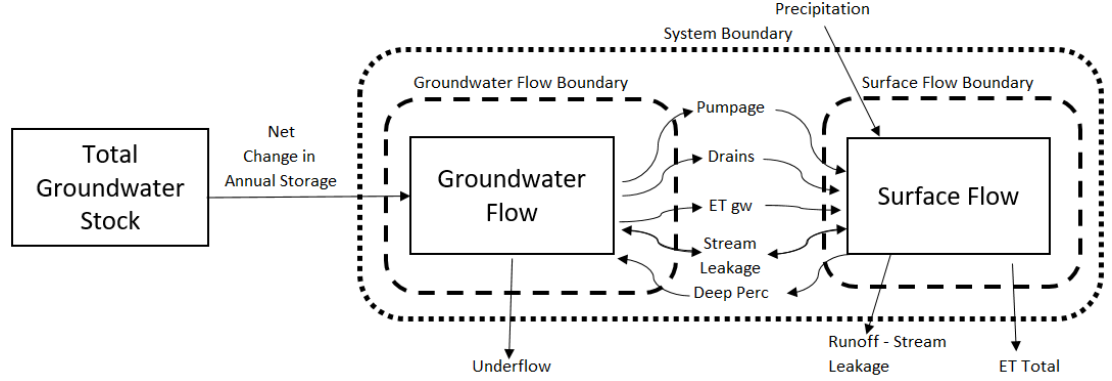
Figure 2. Cuyama groundwater system.